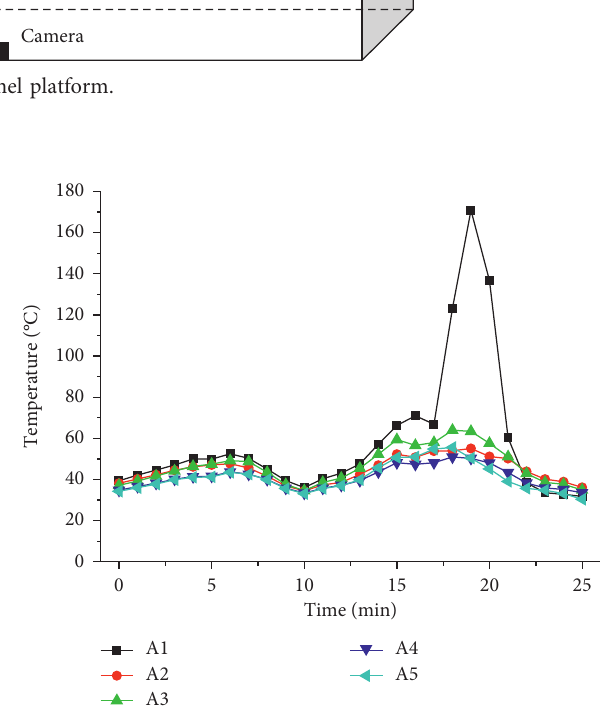
Figure 4: Temperature curves in the tunnel with a single cable with a fan frequency of 11 Hz.